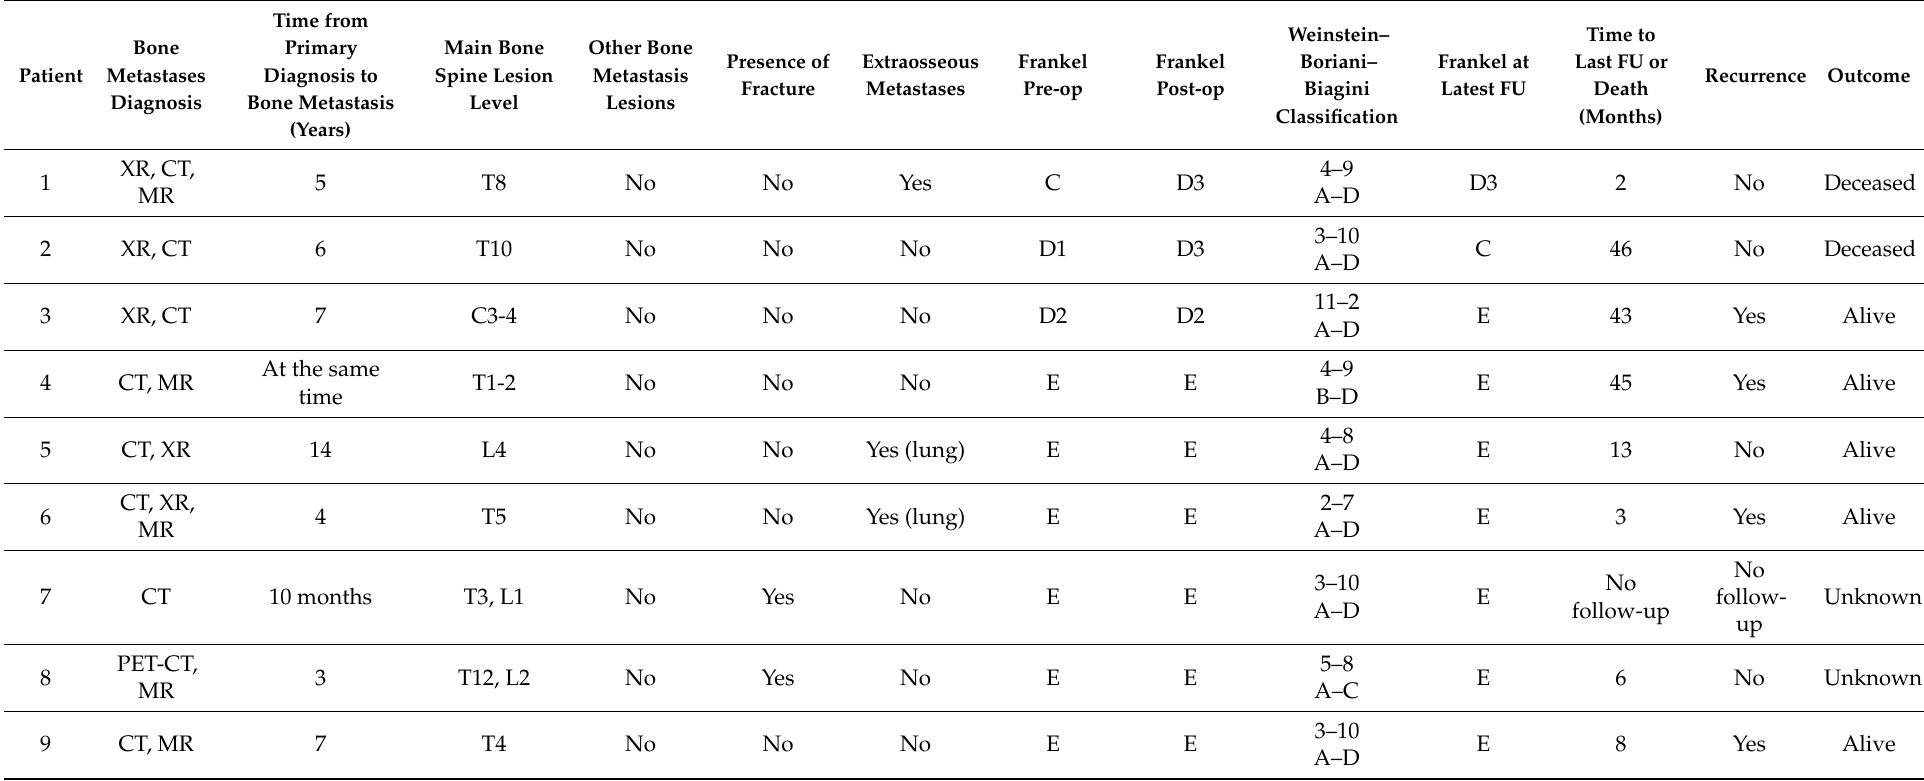
Table 3. Clinicopathologic characteristics of bone metastasis from LMS (n =